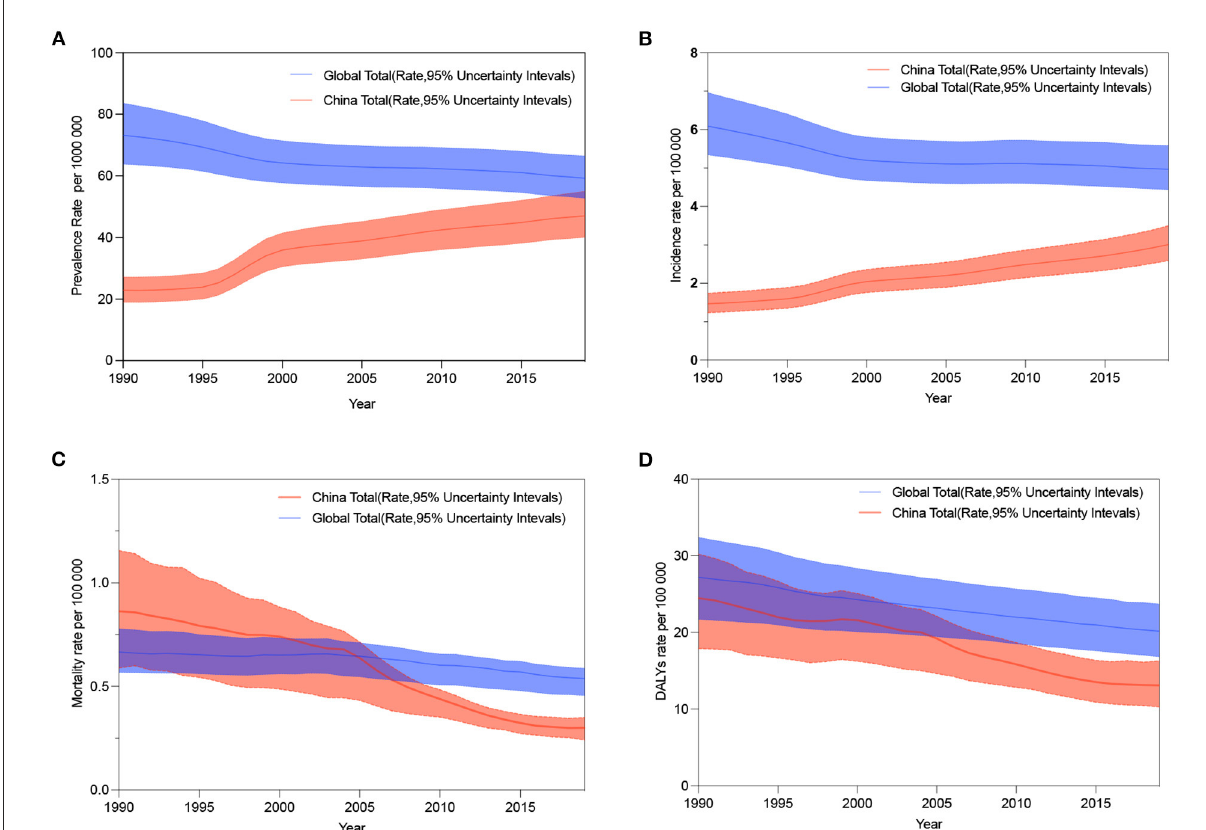
FIGURE8 The age-standardized prevalence, incidence, mortality, and DALYs rates of IBD by both sexes from 1990 to 2019 in China compared with global values. (A) Trends in the age-standardized prevalence rate in China and worldwide. (B) Trends of age-standardized incidence rate in China and worldwide. (C) Trends in the age-standardized mortality rate in China and worldwide. (D) Trends in the age-standardized DALYs rate in China and worldwide.